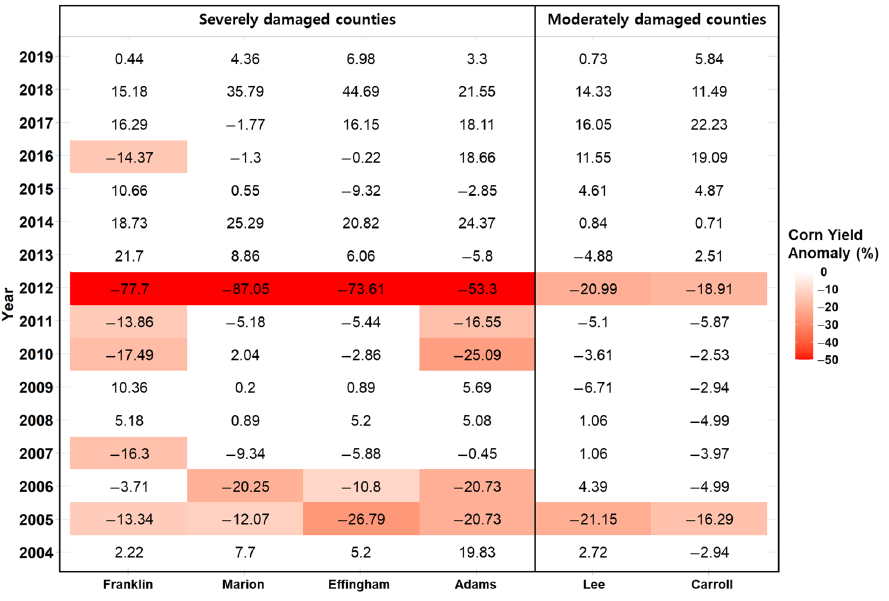
Figure 5. Annual corn yield anomalies for counties with severely and moderately damaged counties in Illinois. Table 4. Severely and moderately damaged counties selected from Illinois,